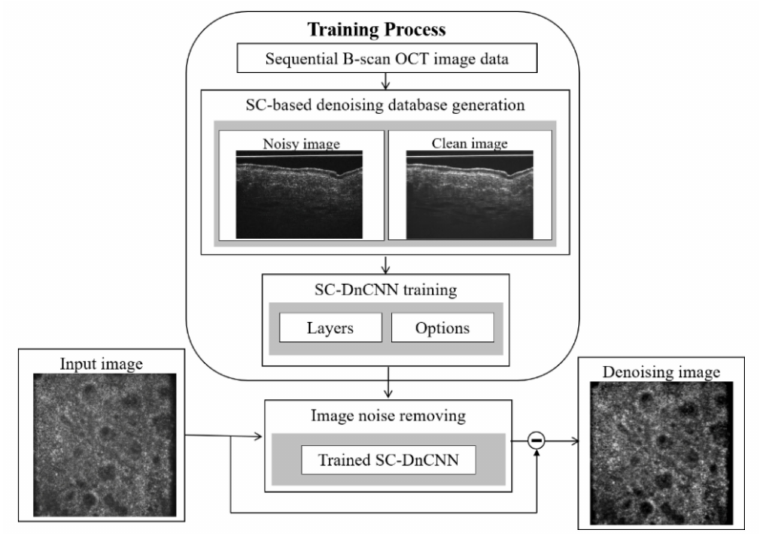
Figure 4. The structure of the spatial compounding-based denoising convolutional neural networks (SC-DnCNN) trained for optical coherence tomography (OCT)